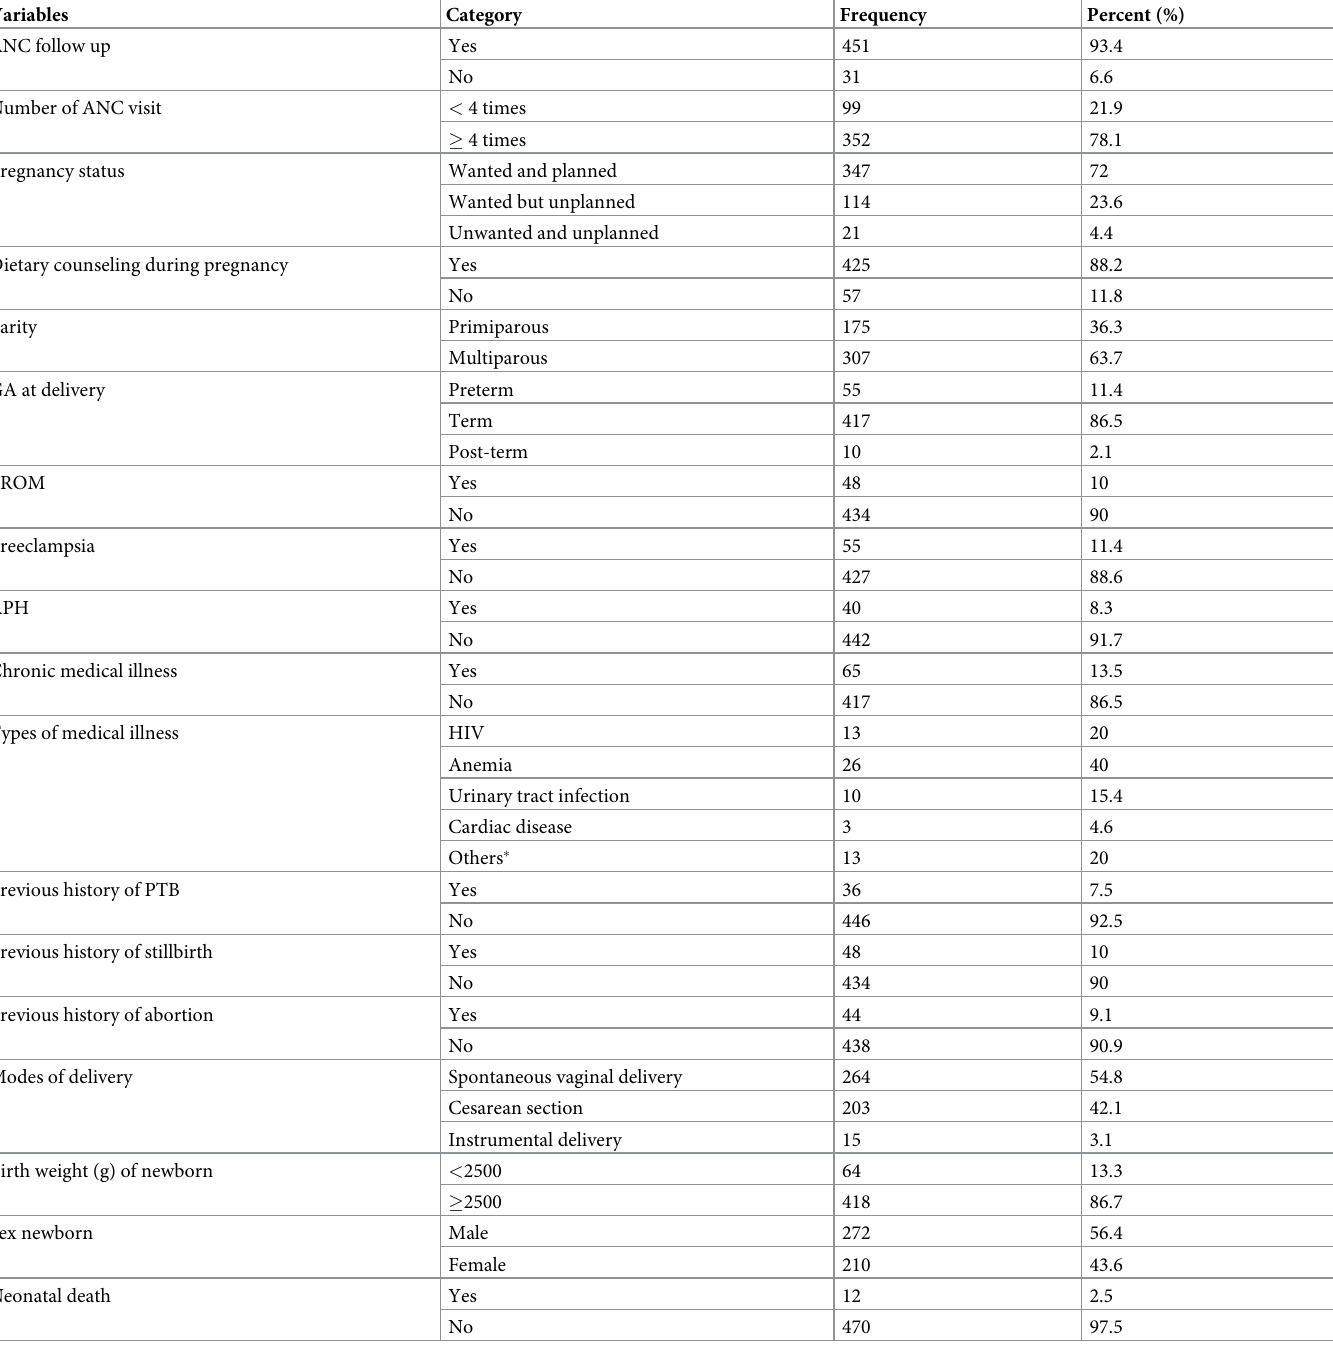
Table 2. Maternal obstetric, medical and newborn characteristics of participants in governmental referral hospital, Amhara Region, Northwest, Ethiopia 2020 (n =